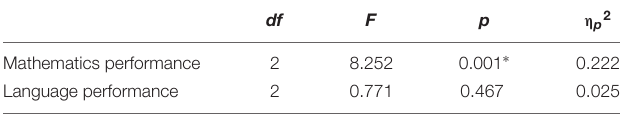
TABLE 5 | Comparison of mathematics and language performance between the TABLE 4 | EFs performance of the experimental and the control groups, experimental and the control group at T3, controlling for EFs performance at T1. compared between T1 and T2 and between T1 and T3. Df F P η p 2 df F p η p T1-T2 performance difference 2